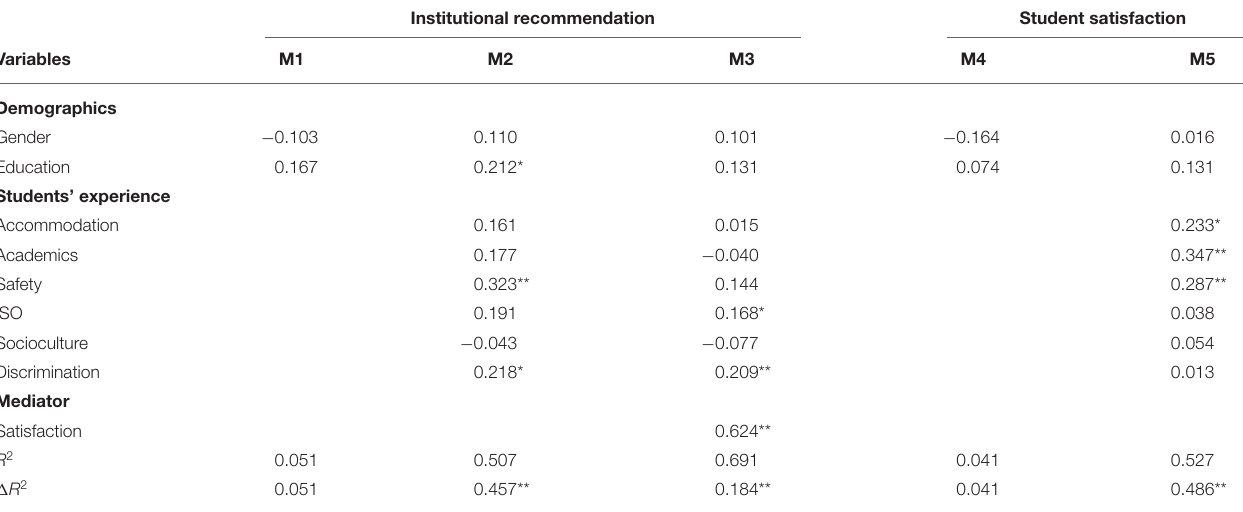
TABLE 4 | Results of African